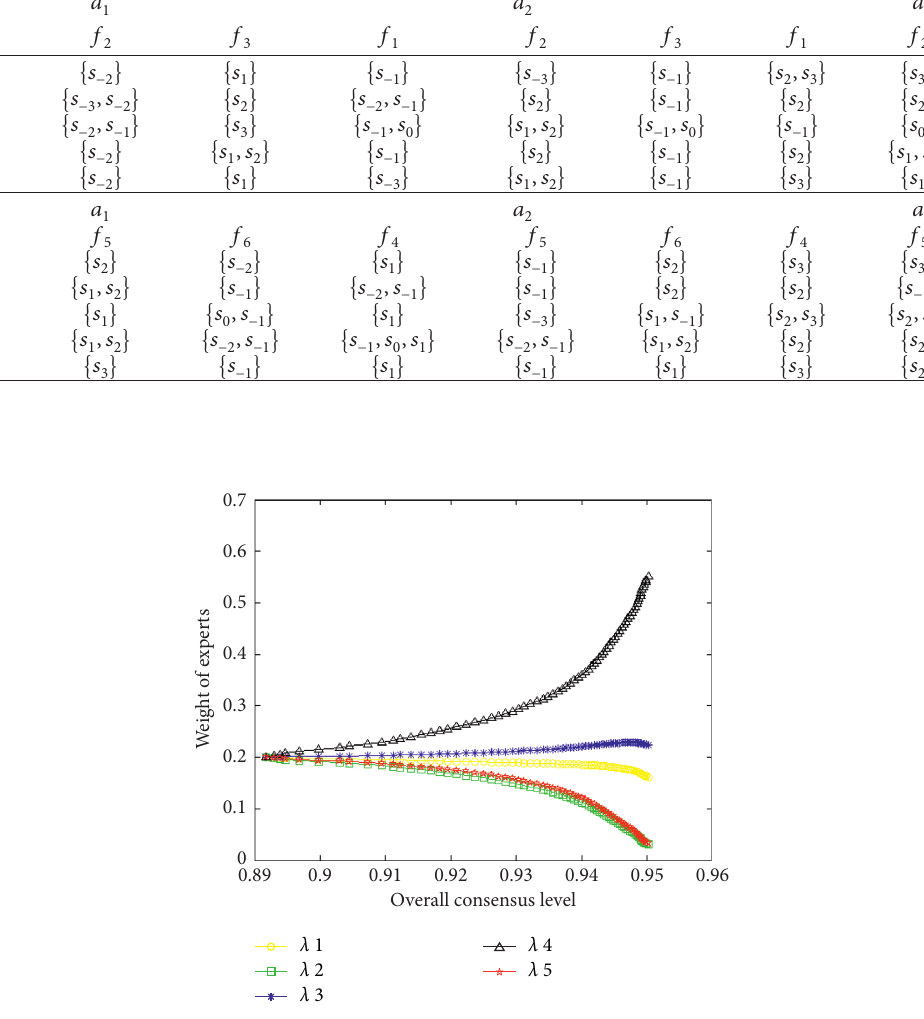
Figure 3: The change of expert adaptive weight and global consensus degree.